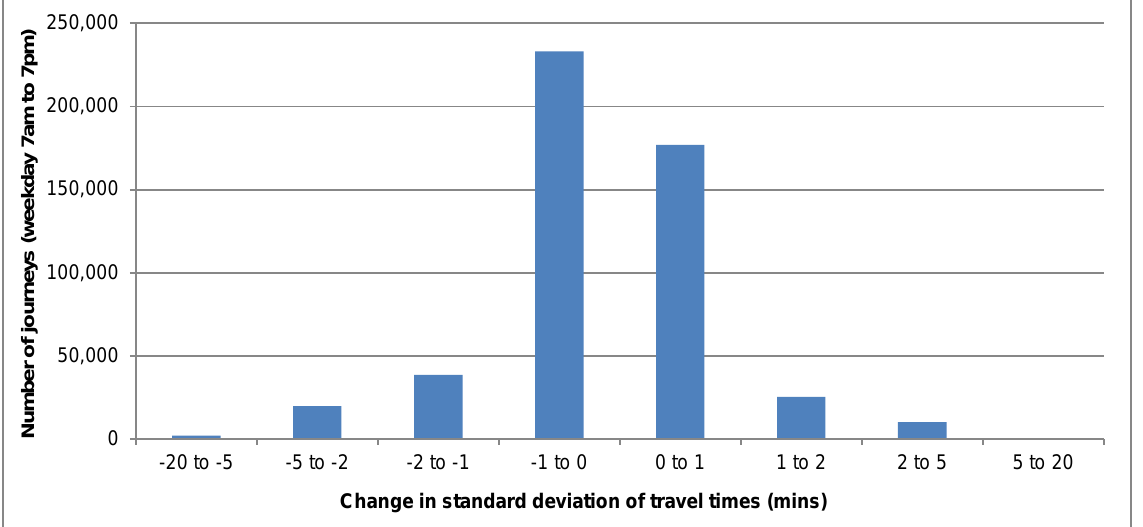
Figure 12. Distribution of change in standard deviation of travel time over travellers